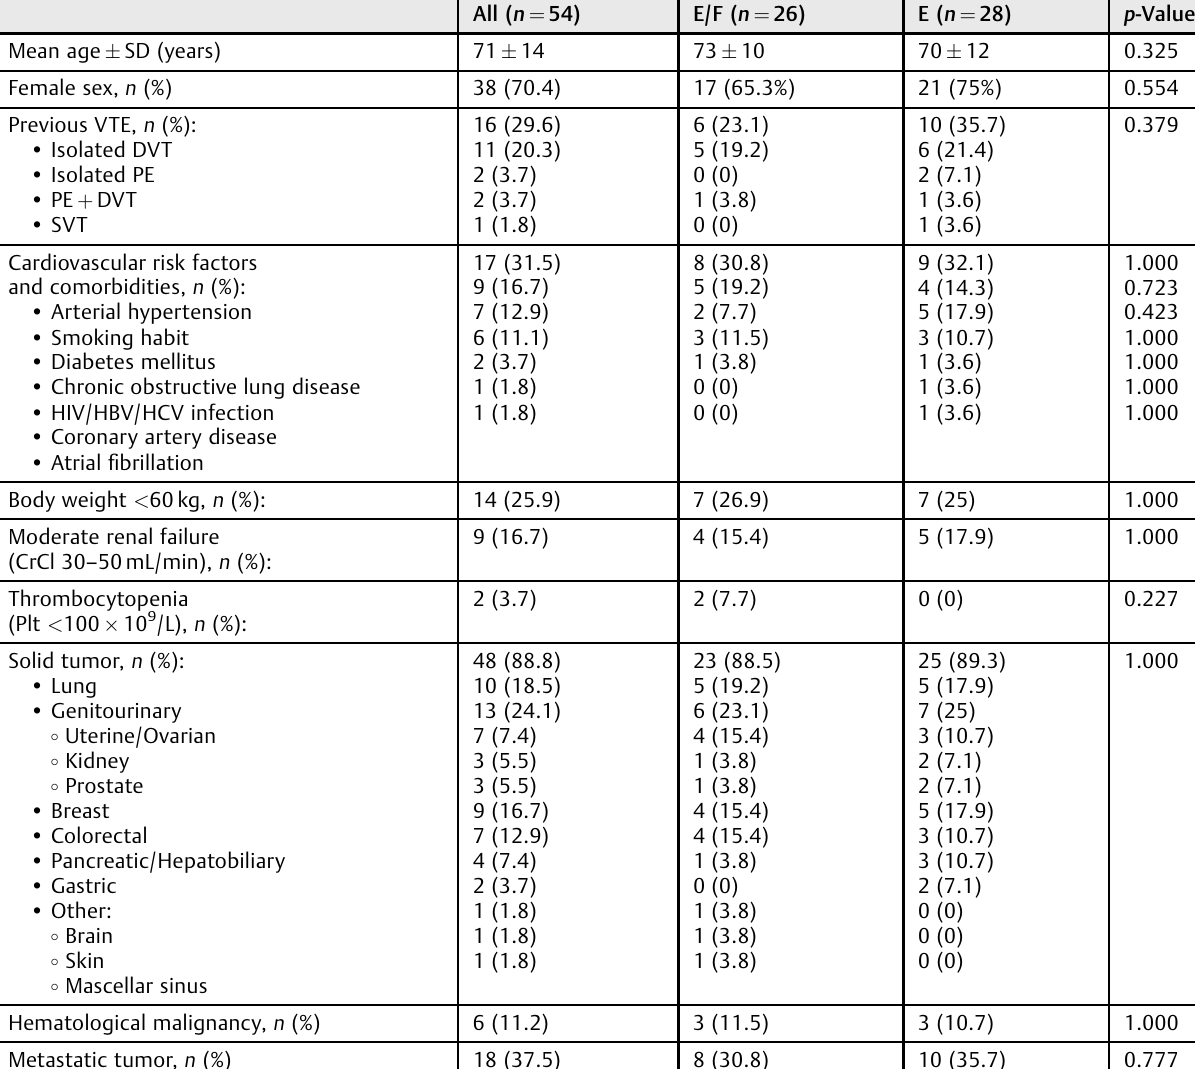
Table 1 Baseline characteristics of patients: all patients, and comparison between patients treated with enoxaparin/fondaparinux and those treated with edoxaban in the post-acute phase of cancer-associated VTE All ( n ¼ 54) E/F ( n ¼ 26) E ( n ¼ 28) p -Value Mean age (cid:1) SD (years) 71 (cid:1) 14